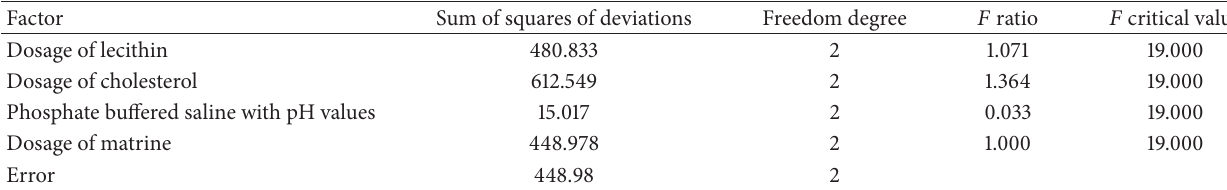
Table 3: Table of variance analysis.